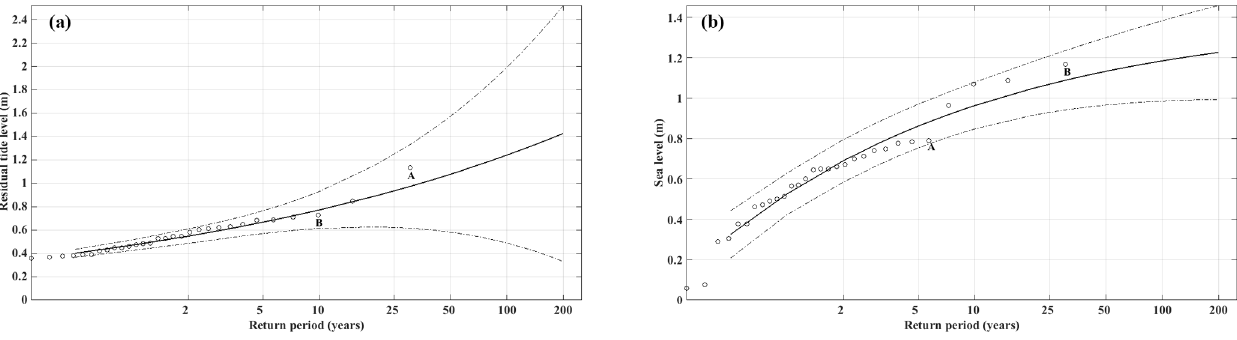
Figure 7. Yearly maximum residual tide heights adjusted to the GEV distribution probability function for Progreso (2km offshore). The solid curve is the fitted curve. The dots correspond to the 30 events with (a) the yearly maximum residual tide, and (b) the yearly maximum sea-level elevation. The dashed curves are the 95% confidence